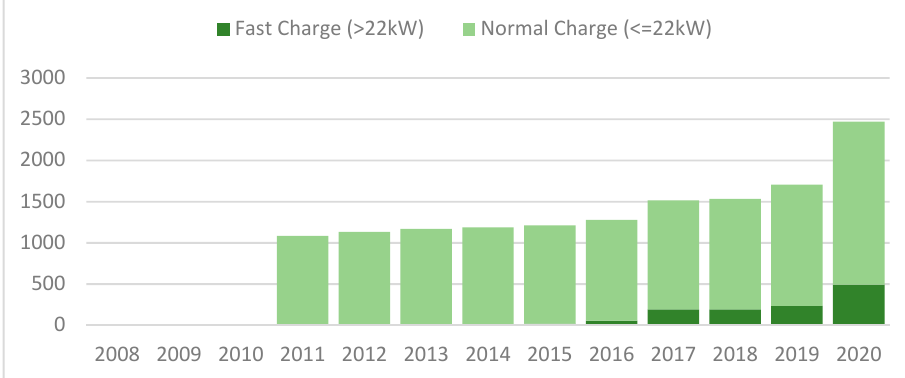
Figure 9. Total number of Normal and Fast public Charging points (2020) [29].